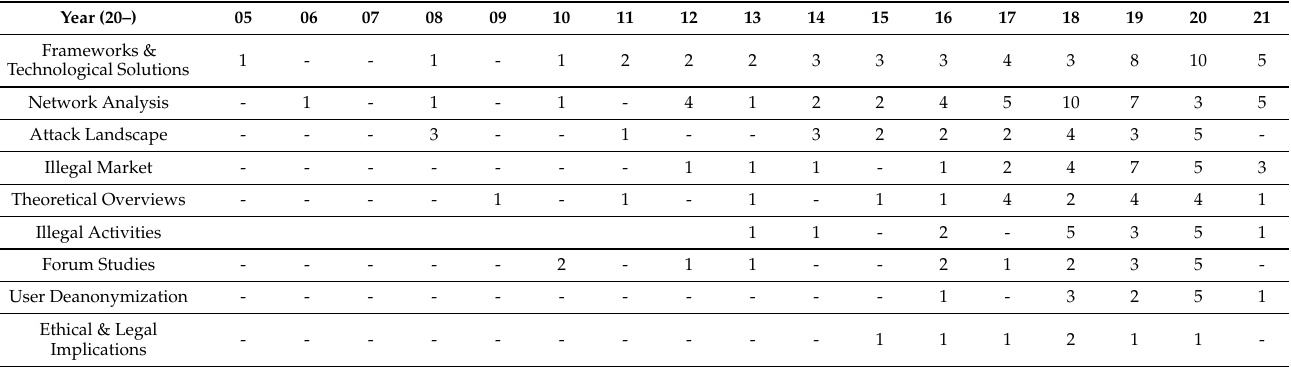
Table 3. Summary of the timeline of the papers by themes. All papers were published after the year